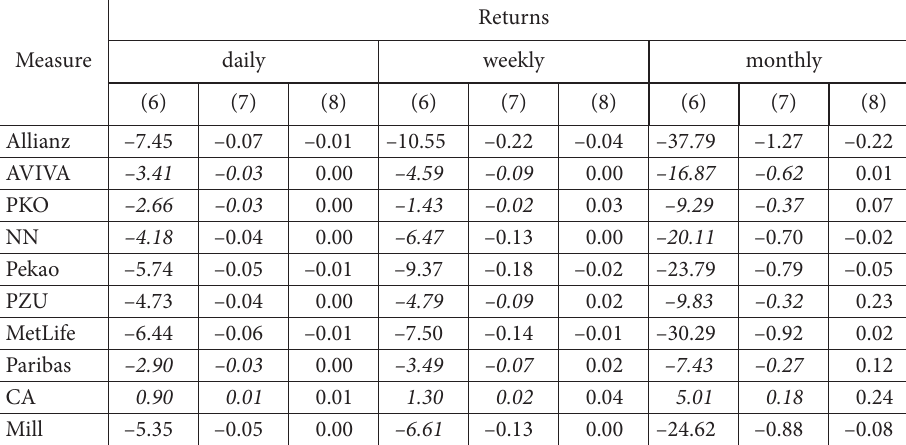
Table 18. Average values of Sharpe, Treynor and Jensen efficiency ratios evaluated for mutual funds for period g (source: own calculations) Returns Measure daily weekly